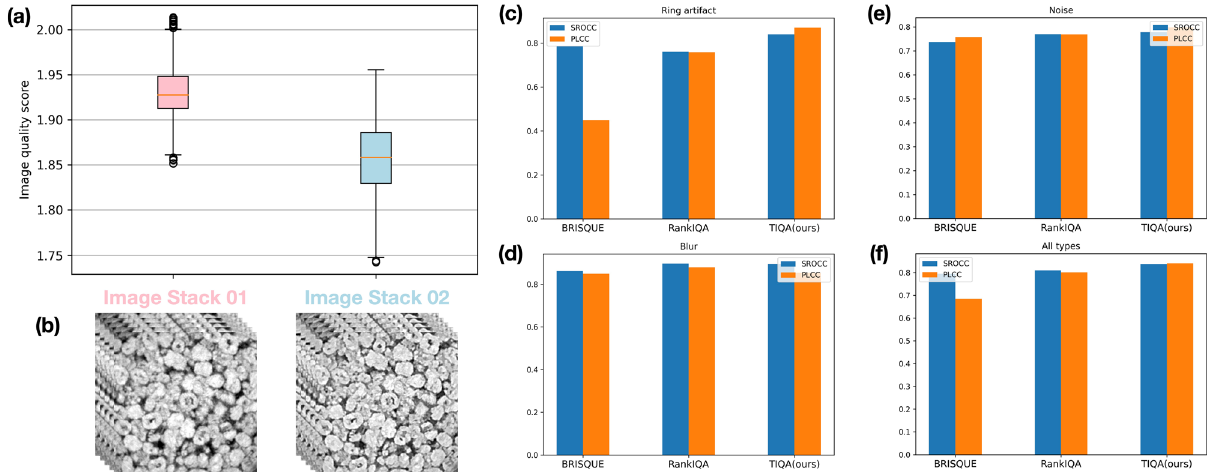
Fig. 4 Image quality prediction results of two image volumes. a Shows the box fi gure of the prediction results while ( b ) demonstrates the tested image volumes. They both are from the same material, but the volume Image Stack 01 has better quality than the volume Image Stack 02. The fi gure on the right shows the predicted quality score of the two volumes. The line in the box is the mean value of all scores. Quantitative comparison among different methods. c – e Show the results of assessing the images with ring artifact, noise, and blur distortion, respectively. The last fi gure ( f ) illustrates the results of different methods for all types of